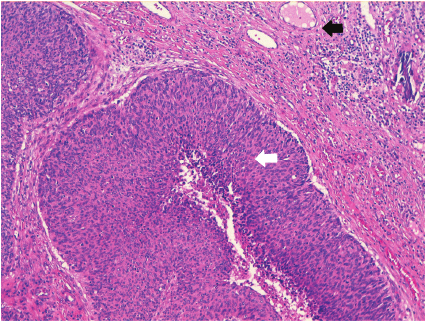
Figure 1: Histopathologic report: noninvasive squamous cells carci- noma (white arrow) without angiolymphatic invasion (black